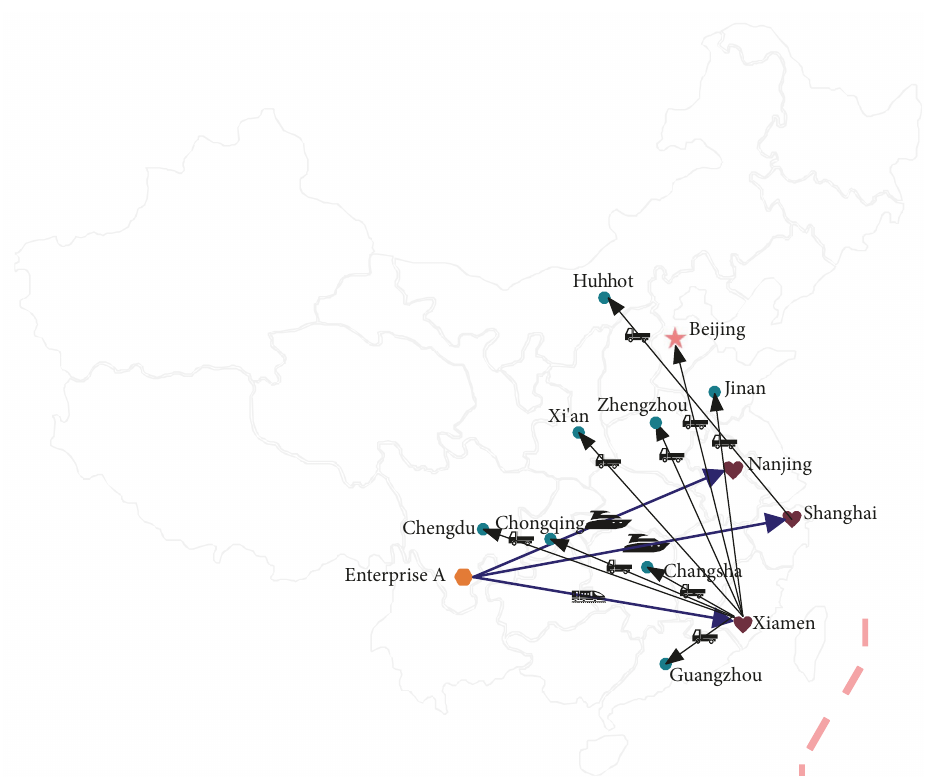
Figure 11: Optimal solution by maximizing social influence of Enterprise A,